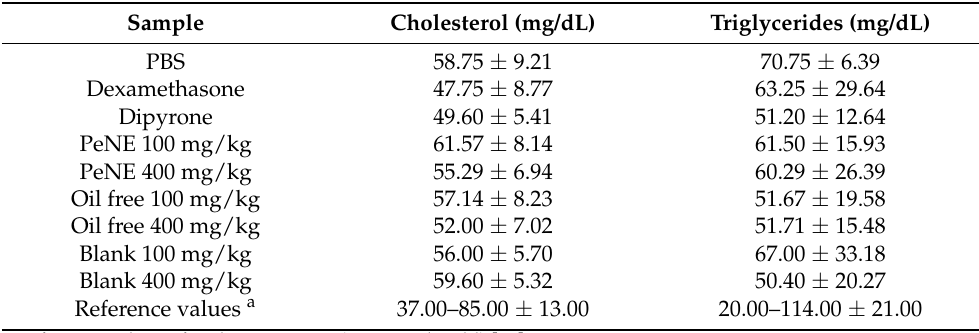
Table 3. Cholesterol and triglycerides analyses from the blood samples of rats after oral treatment with PeNE or free pequi oil for 15 days.